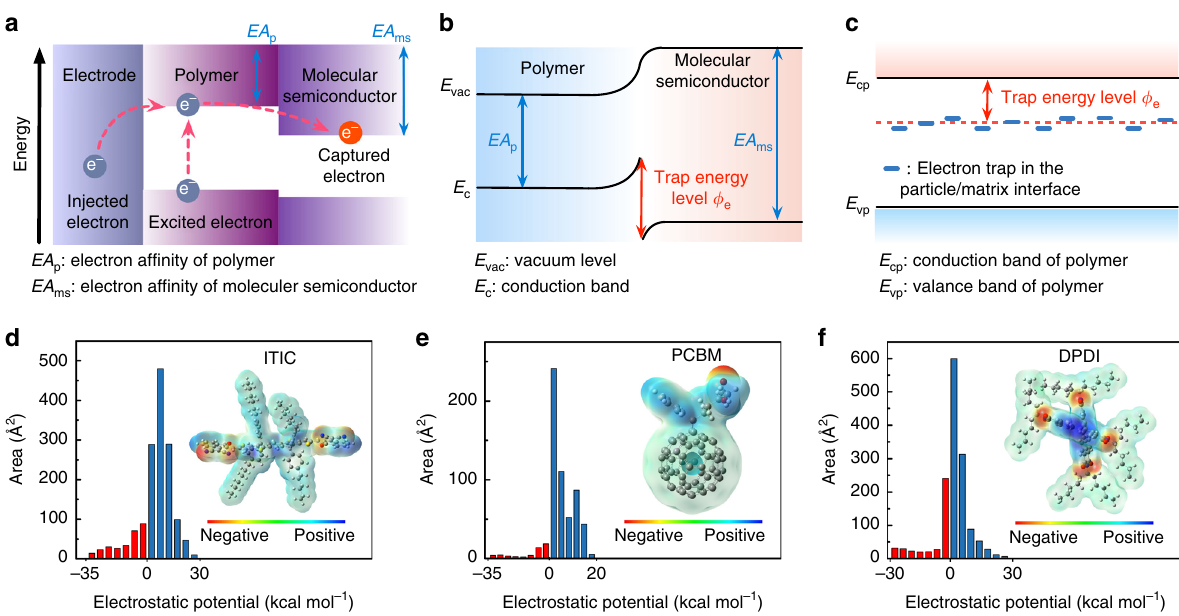
Fig. 1 Design of the dielectric polymer/molecular semiconductor all-organic composite. a Band diagram showing the possible charge transfer in the all- organic composite. b Schematic illustration of trap energy level introduced by the molecular semiconductors in the all-organic composite. The trap energy level can be calculated using Φ e = EA ms − EA p , where EA ms and EA p are the electron af fi nities of the molecular semiconductor and the dielectric polymer, respectively. c Schematic representation of the trap energy level in polymer/insulating particle nanocomposites introduced through modi fi cation of polymer chain conformation and arrangement in the particle/matrix interfaces. The electron traps are located in the forbidden gap and close to the conduction band of the dielectric polymer. d – f Electrostatic potential distribution and area percentage in each electrostatic potential range of ITIC, PCBM, and